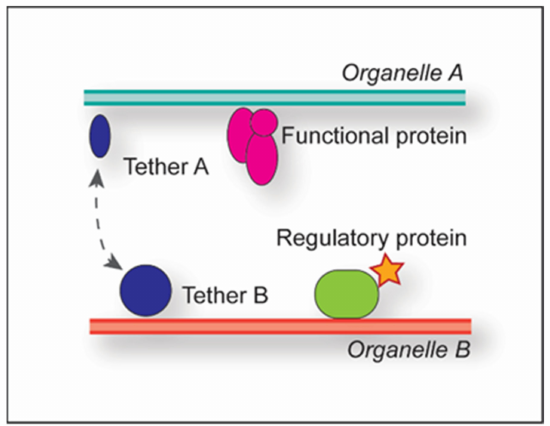
Figure 1. Classification of proteins in MCSs. MCS-associated proteins can be classified into tether pairs present on both organelles (indicated by A and B) (blue), functional proteins (pink) and regulatory proteins (green). The dashed grey line highlights interaction. The red star indicates